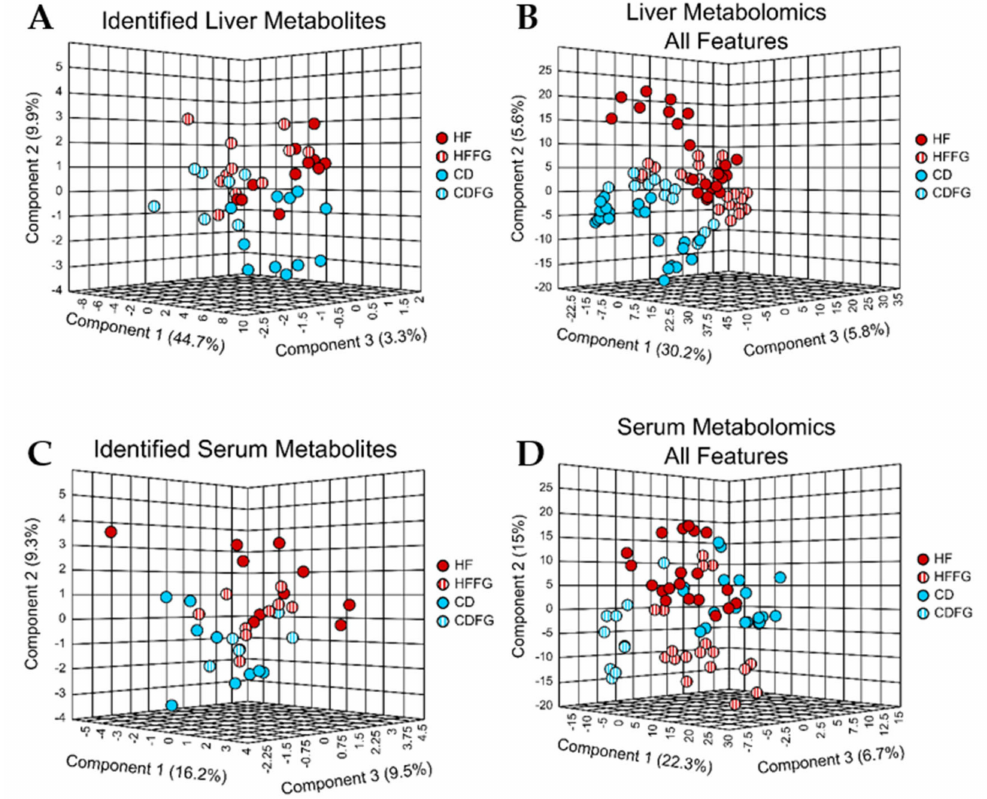
Figure 5. PLS-DA of liver and serum samples reveal subtle distinctions between the metabolic profiles associated with each diet, more notably in the unidentified features. Untargeted metabolomics was performed on the liver and serum samples from mice fed either HF, HFFG, CD, or CDFG diets. PLS- DA were performed for ( A ) identified liver metabolites, ( B ) all liver spectral features, ( C ) identified serum metabolites, and ( D ) all serum spectral features. Cross validation values can be found in Supplementary Table S1. Experimental replicates are shown; HF samples are shown in red, HFFG samples are shown in red stripes, CD samples are shown in blue, and CDFG samples are shown in blue